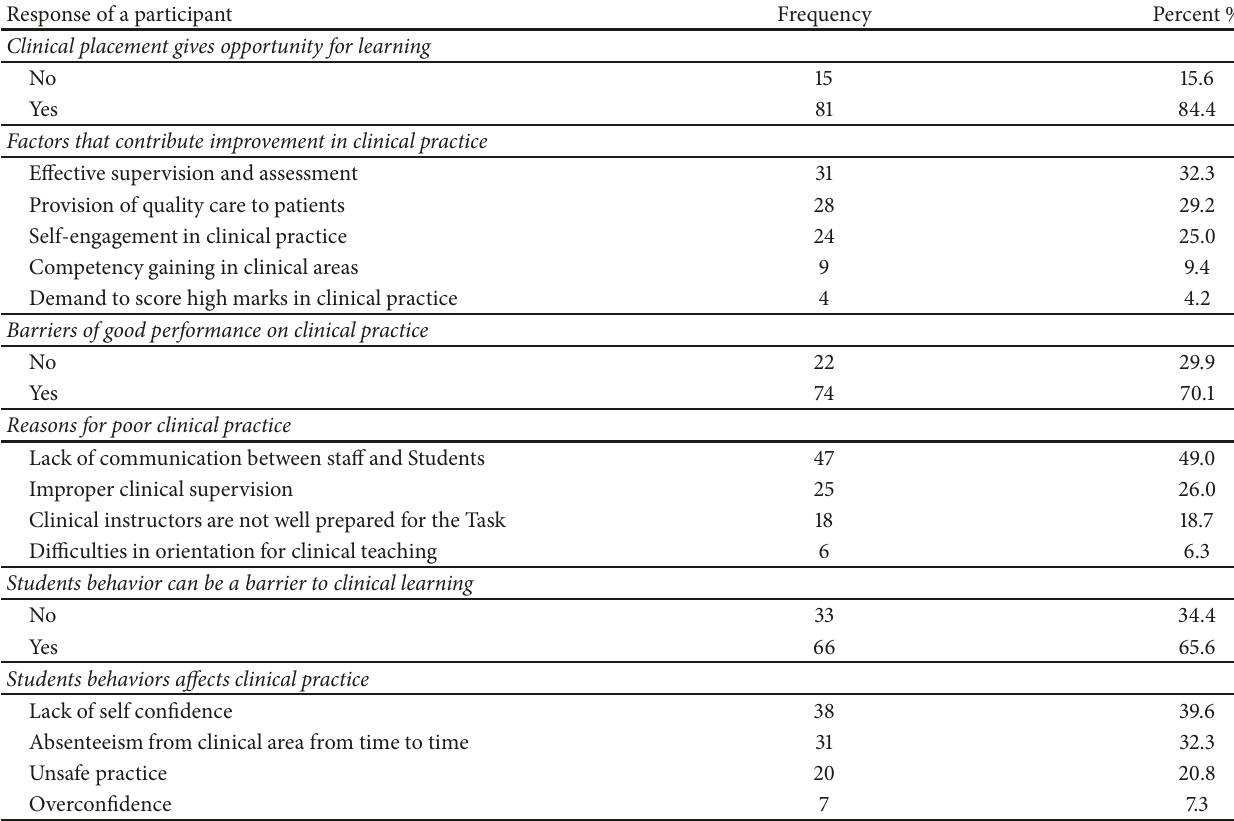
Table 3: Factors related to effective clinical practice by nursing students (n=96).